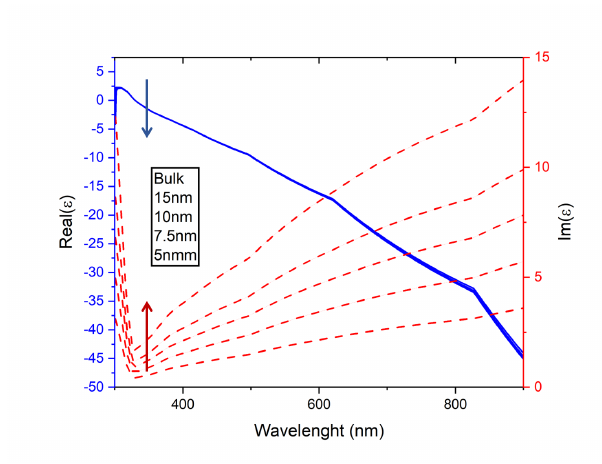
Figure 3: Interpolated silver permittivity experimental data and its correction as function of the wavelength with the thickness as a parameter, Blue(red) curves represent the permittivity’s real(imaginary) part.